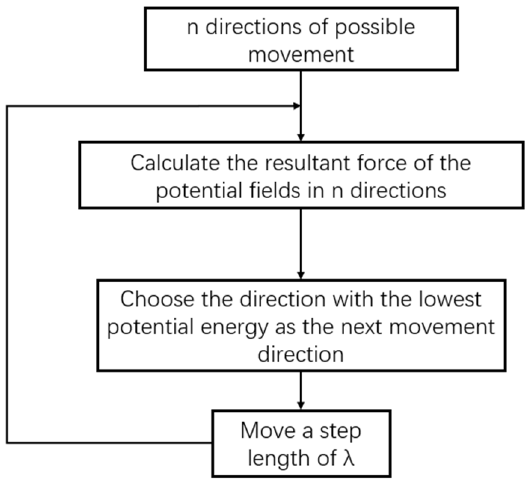
Figure 13. Path planning diagram in a simplified artificial potential field.